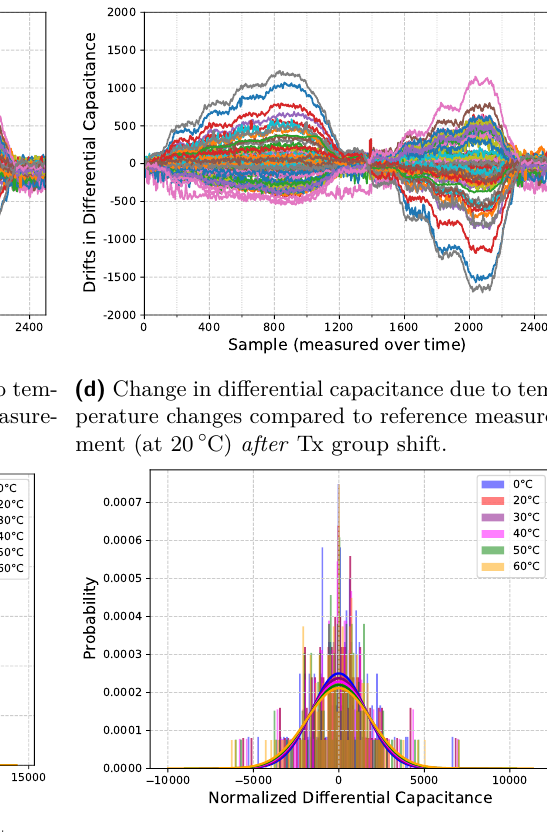
(a) Raw differential capacitance under temper- ature change (compare to Fig. 4). Data taken from [ION + 19].